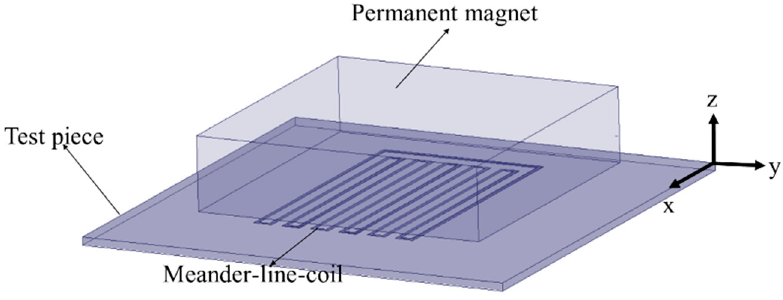
Figure 1. The configuration of a typical meander-line-coil electromagnetic acoustic transducer (EMAT). Reproduced with permission from [15], IEEE, 2016.